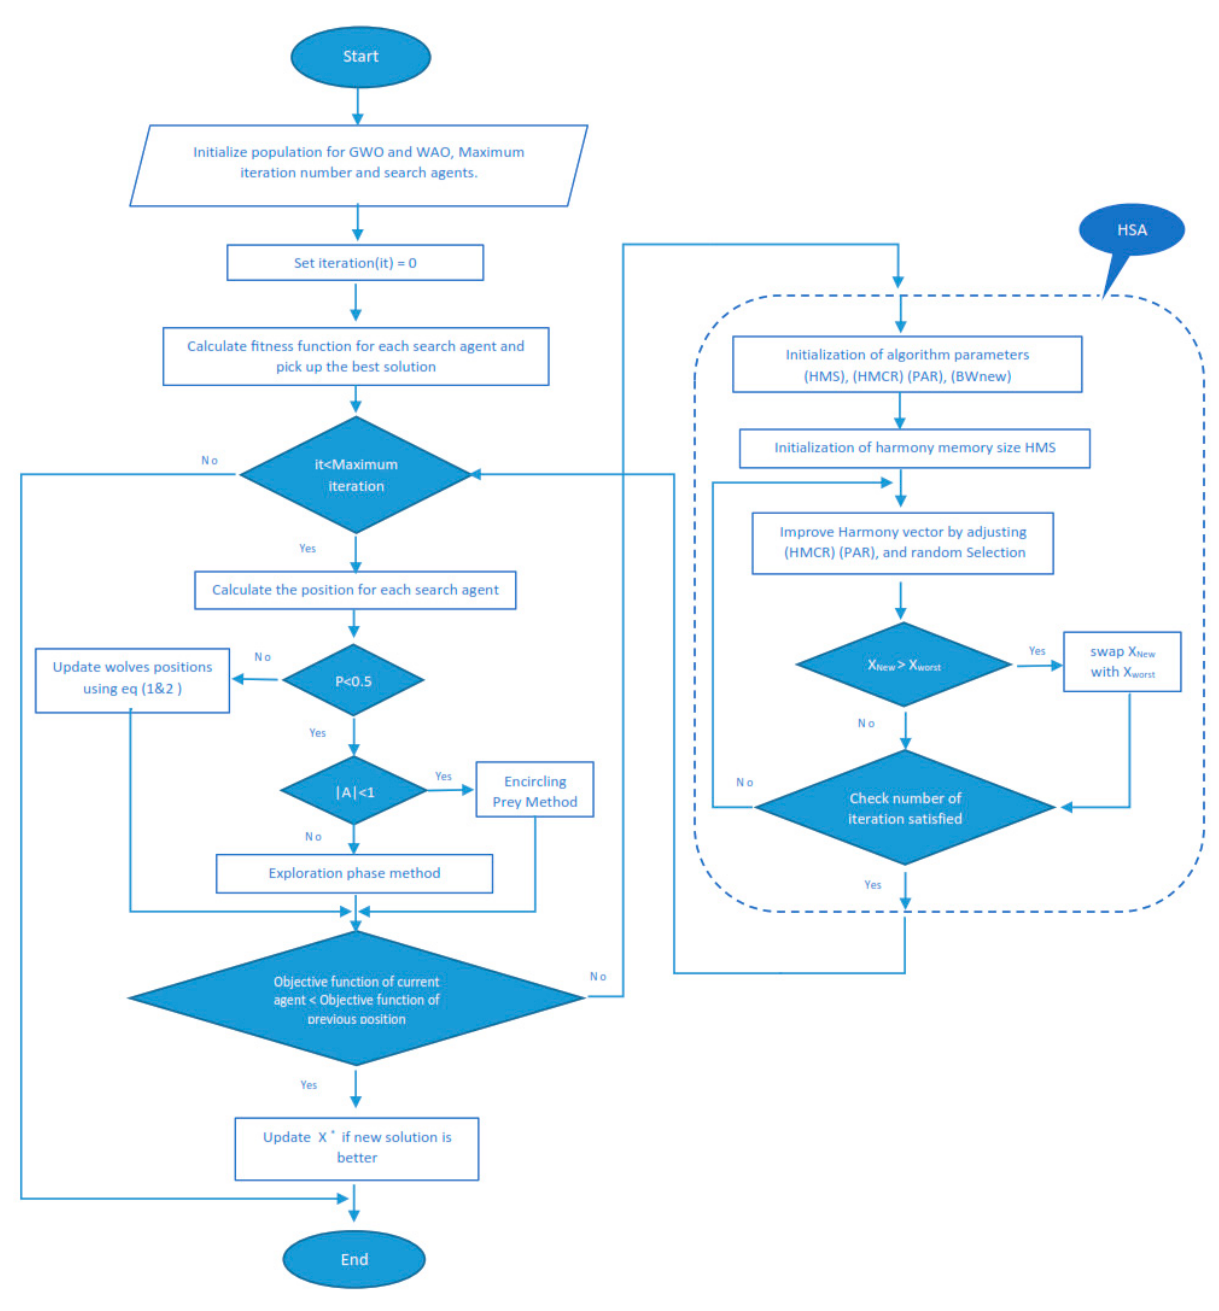
Figure 1. The proposed TWGH.